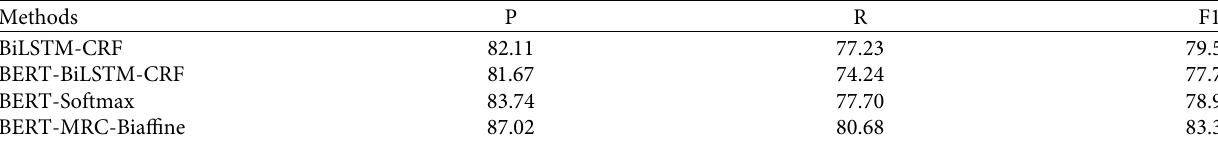
Table 6: The result for the TCM dataset.